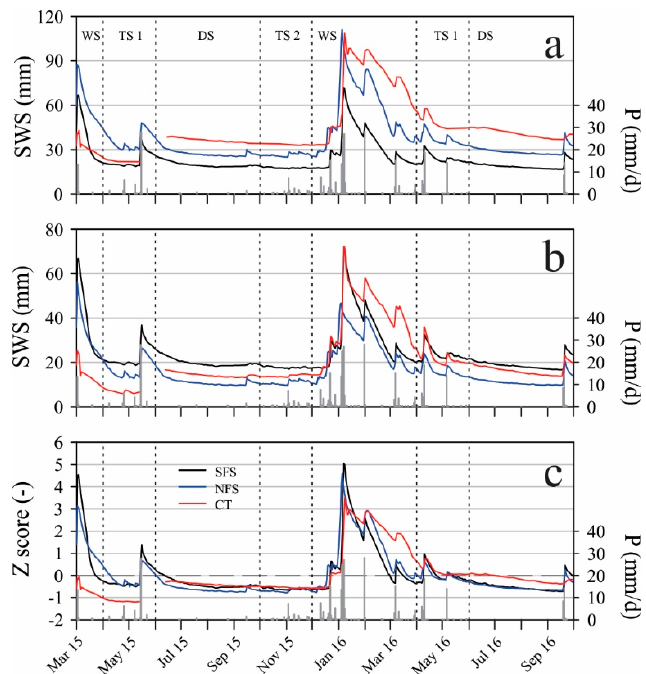
Figure 7. ( a ) Daily soil water storage in each profile up to 1 m depth, ( b ) daily soil water storage in each profile up to 0.4 m depth and ( c ) standardized daily SWS (Z) value for each profile-site, along with daily precipitation.